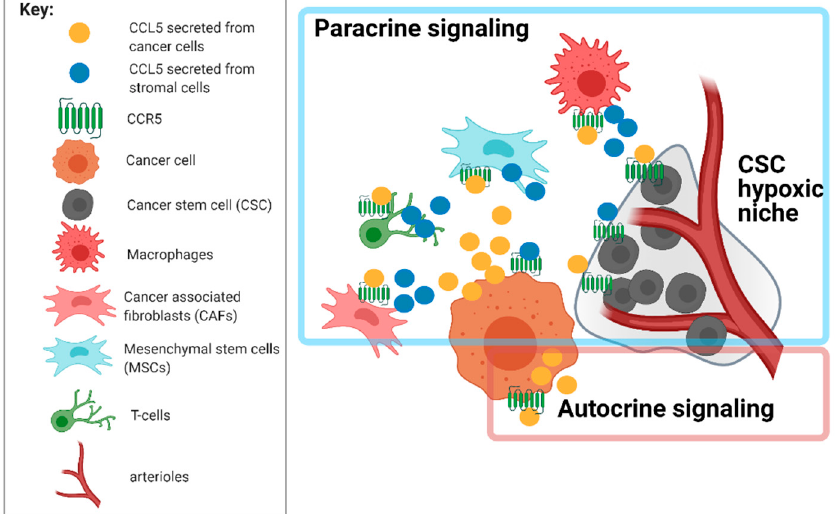
Figure 2. CCL5–CCR5 signaling in cancer microenvironment (created with BioRender.com). Various cell types in the GBM tumor microenvironment express both CCL5 and its receptor CCR5, contributing to cancer progression and cancer stem cell homing to their niche. GBM cells expressing CCR5 can be activated by stromal cells secreting CCL5 in paracrine signaling. Stromal cells expressing CCR5 can be activated by cancer cells secreting CCL5. In high-grade gliomas, cancer cells may establish an autocrine chemokine stimulation, becoming independent of the stroma.